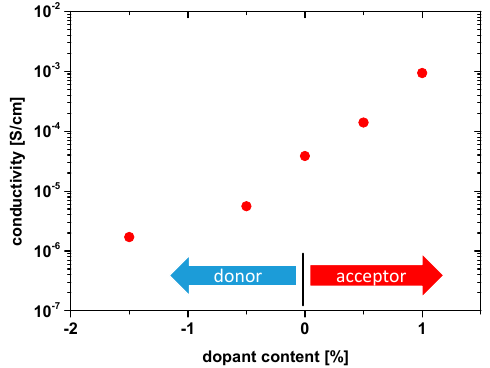
Figure 8. Bulk conductivity values of differently doped PZT at 560 °C in ambient air; negative dopant concentrations refer to donor dopant (La), positive to acceptor dopant (Fe).